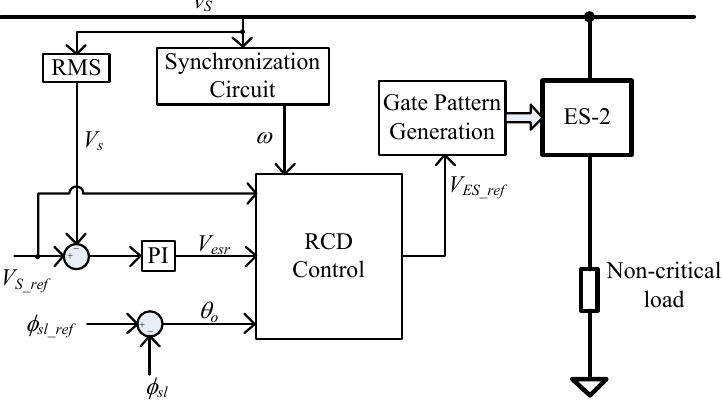
Figure 3. Radial-chordal decomposition control [12].